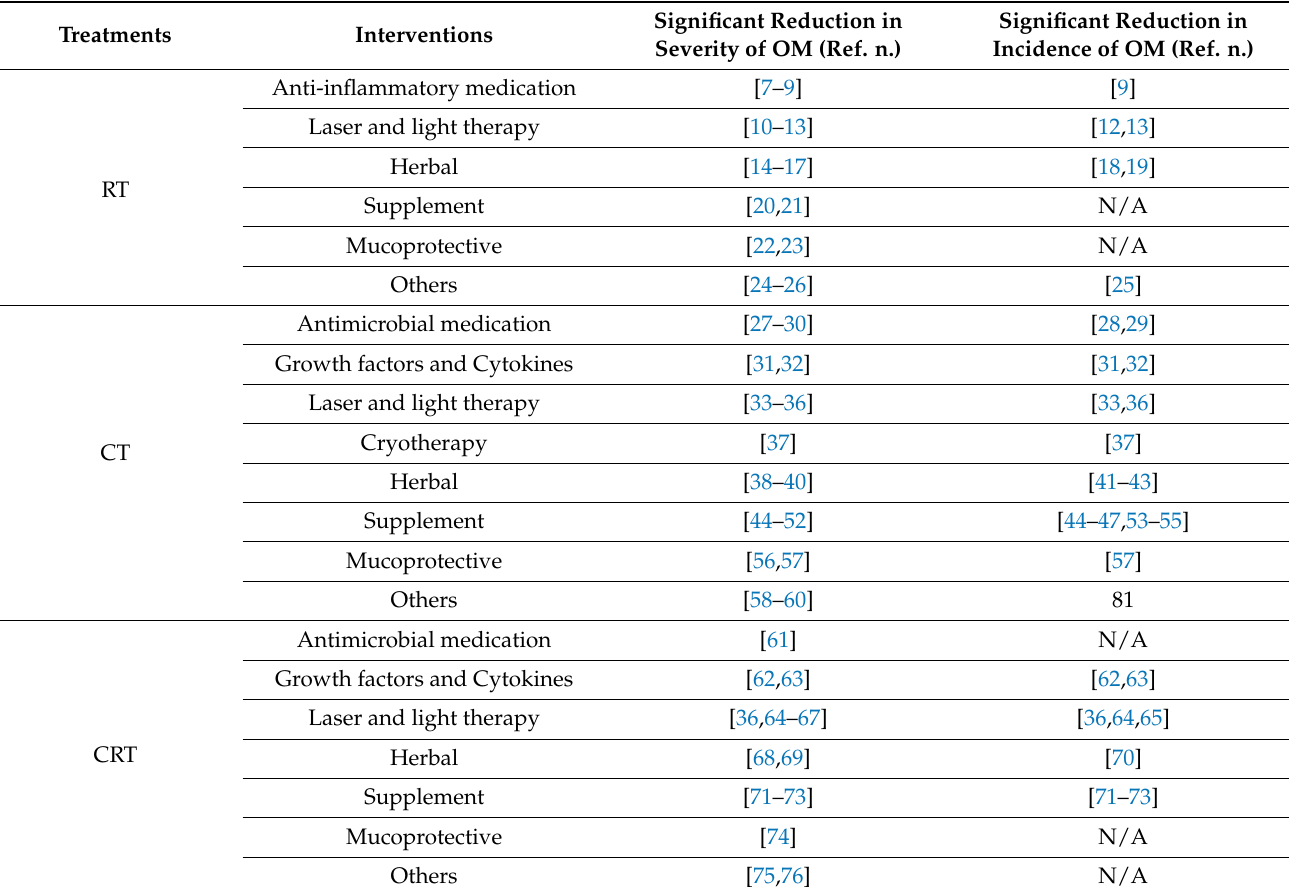
Table 1. Sample of studies with significant reduction in severity or incidence of oral mucositis. OM, oral mucositis; RT, radiotherapy; CT, chemotherapy; CRT, chemoradiotherapy. Significant Reduction in Significant Reduction in Severity of OM (Ref. n.) Incidence of OM (Ref.